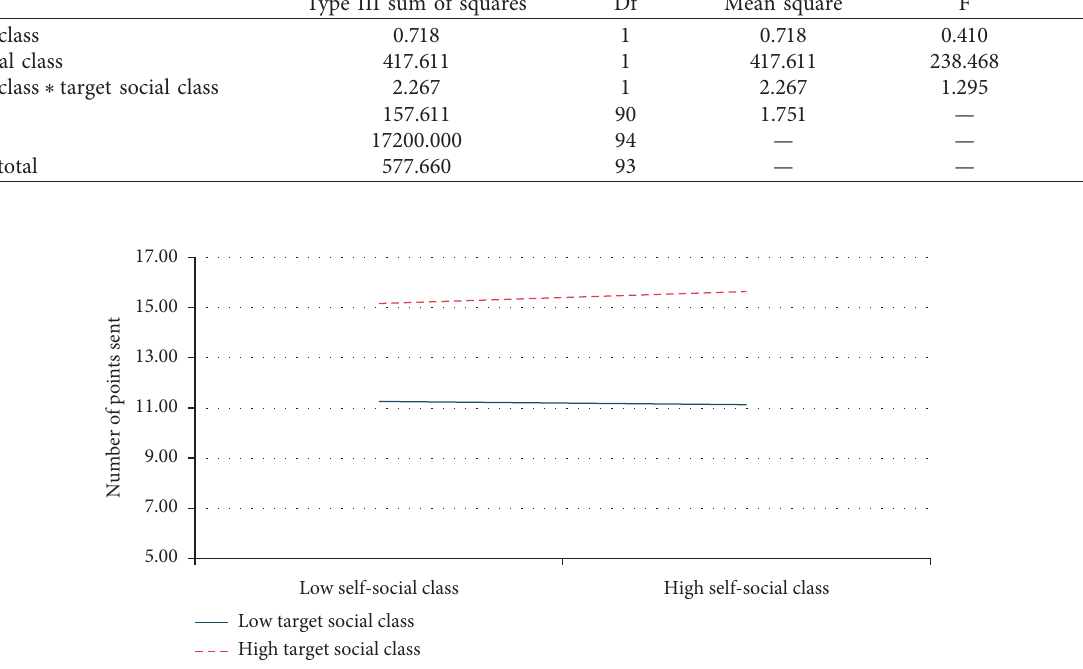
Figure 5: The effect of social class on the number of points in a trust game from China university